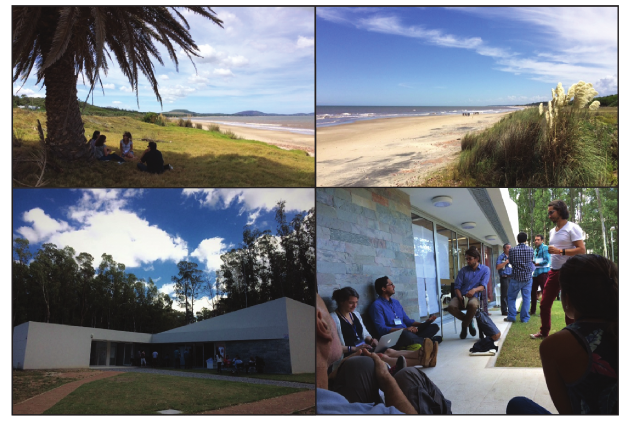
Fig. 2. Images from the first workshop at the South American Institute for Resilience and Sustainability Studies in March